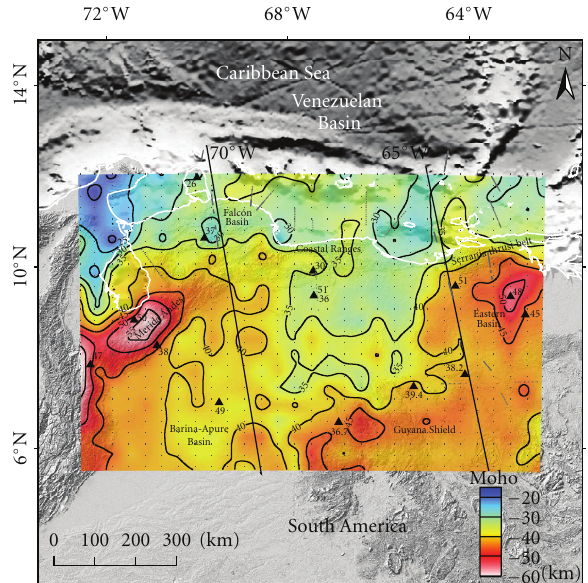
Figure 7: Map of source-depth estimation (Moho) obtained by spectral analysis of gravity data. Triangles are the receiver function Moho depth estimations in kilometers [37]. Gray lines are Moho depths estimated from seismic studies [38]. Location of profiles are shown as black lines labeled by 70W and 65